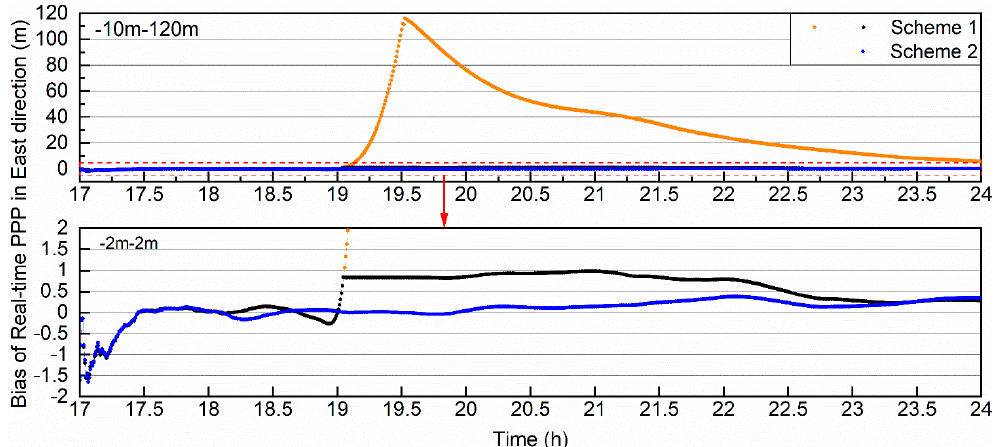
Figure 11. Bias of real-time PPP in the east.